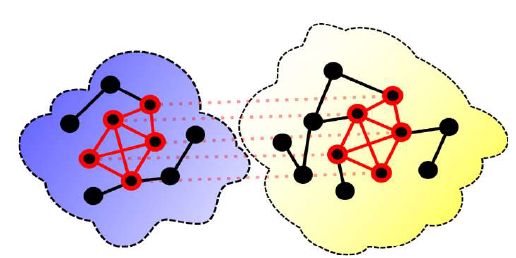
Figure 10. Example of bridging by graph similarities [8]